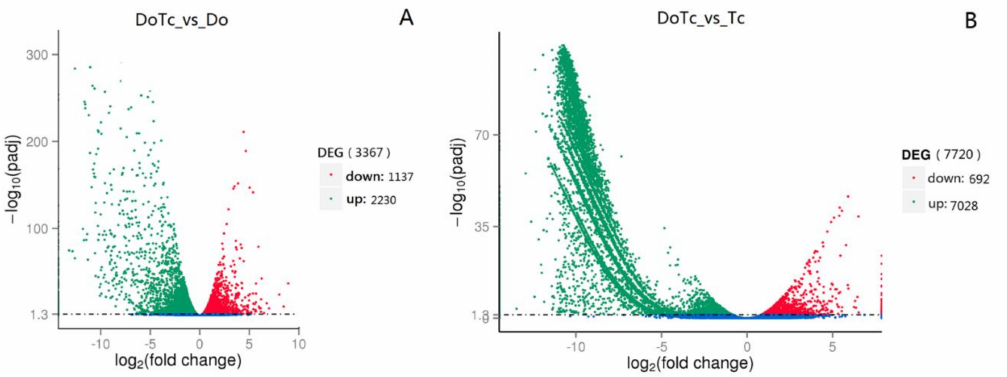
Figure 2. The distribution of differentially expressed genes (DEGs) in symbiotic and asymbiotic germinated seeds. ( A ) DEGs originating from D. officinale in the symbiotic germinated seeds (DoTc vs. Do), and ( B ) DEGs originating from OMF (orchid mycorrhizal fungi) in the symbiotic germinated seeds (DoTc vs. Tc). Genes in which the relative level of expression was down-regulated are shown in red, and those that were up-regulated are shown in